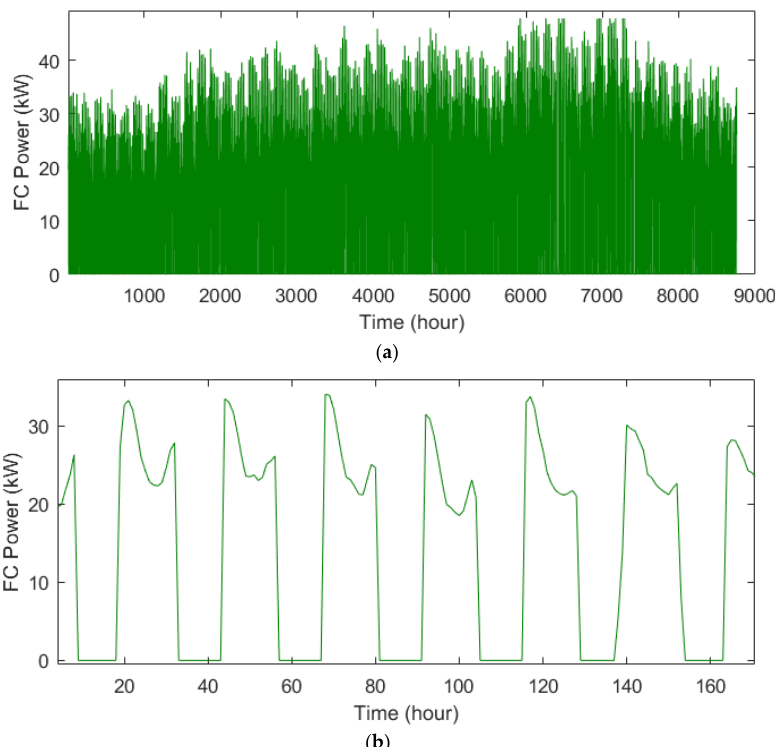
Figure 10. FC power in the sizing of the HPV/FC energy system via the IAEO, considering ENSP max = 1% during ( a ) a year and ( b ) a week.